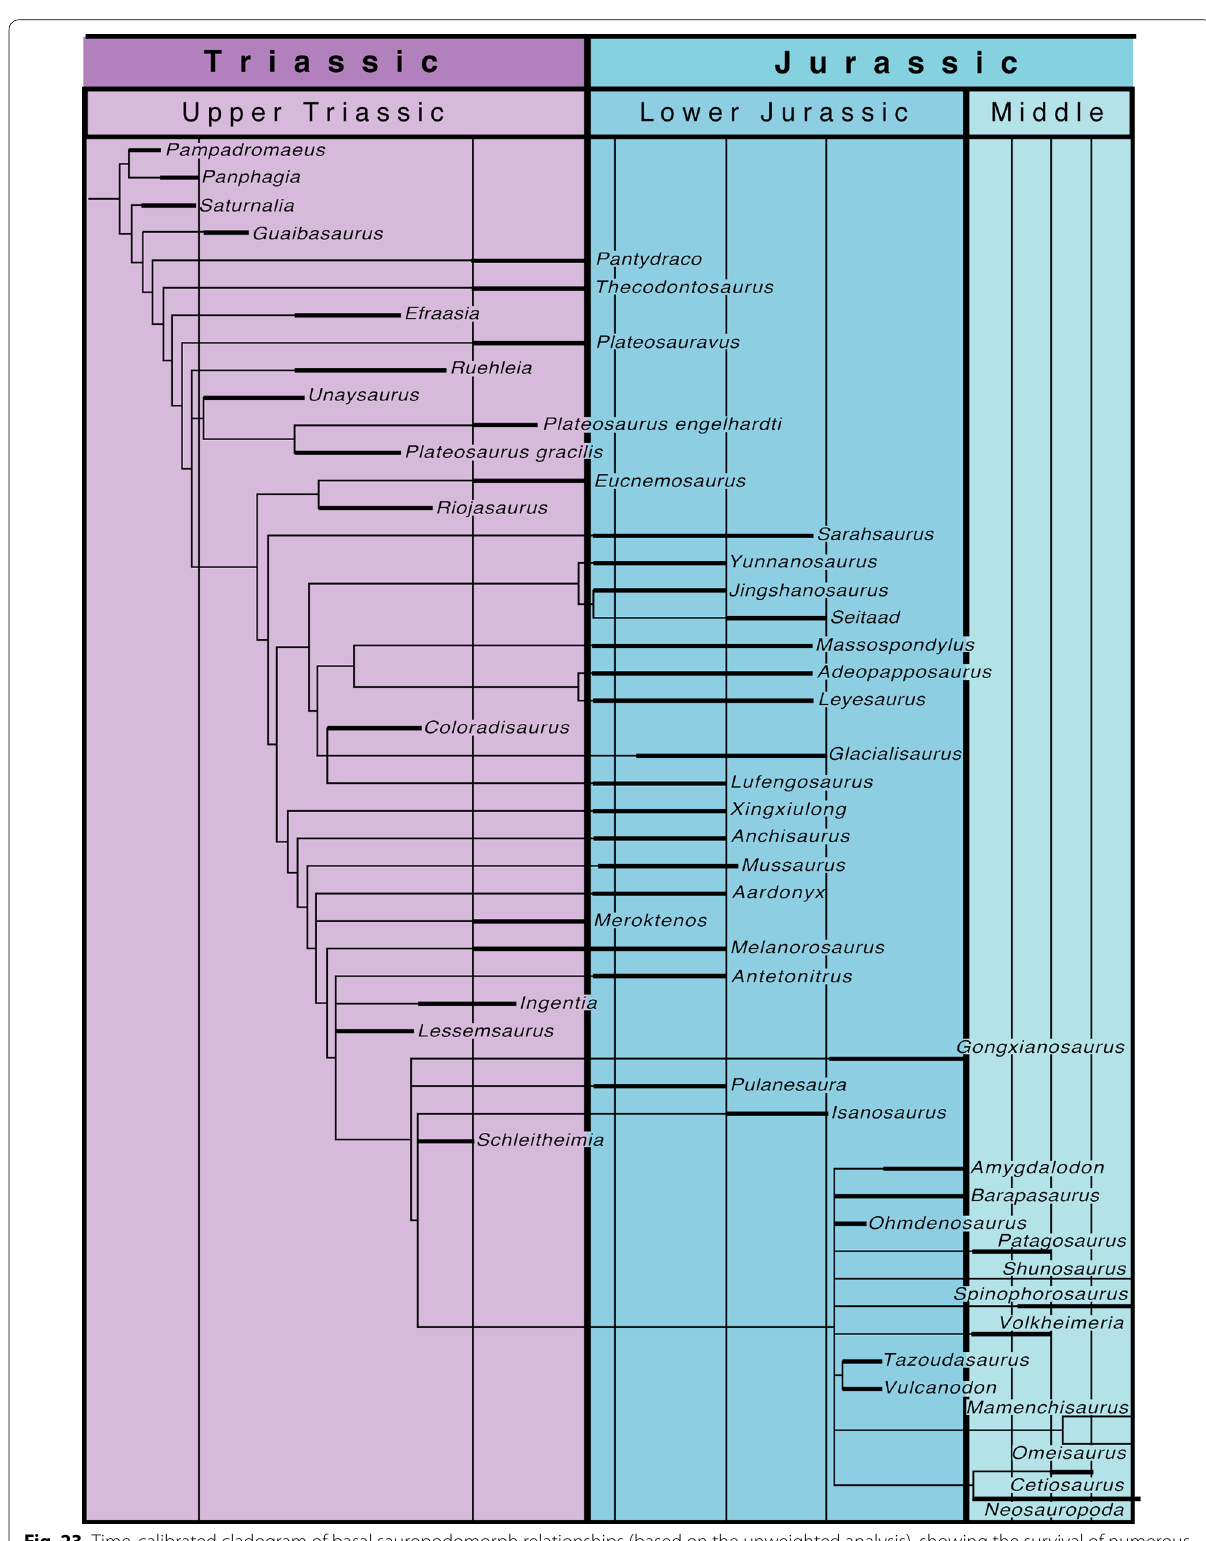
Fig. 23 Time-calibrated cladogram of basal sauropodomorph relationships (based on the unweighted analysis), showing the survival of numerous lineages (including sauropods) across the Triassic-Jurassic